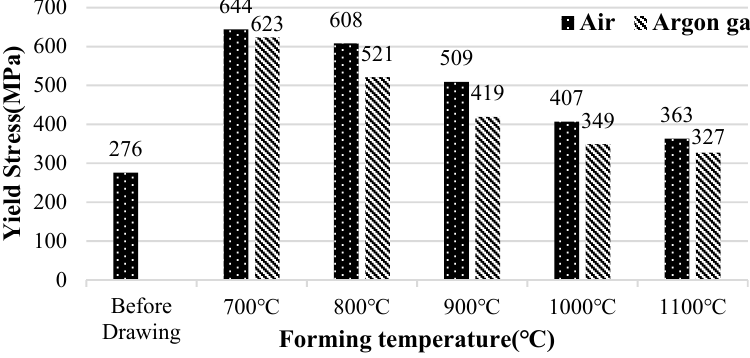
Figure 6. Comparisons of yield stresses of drawn wires in air and argon gas.